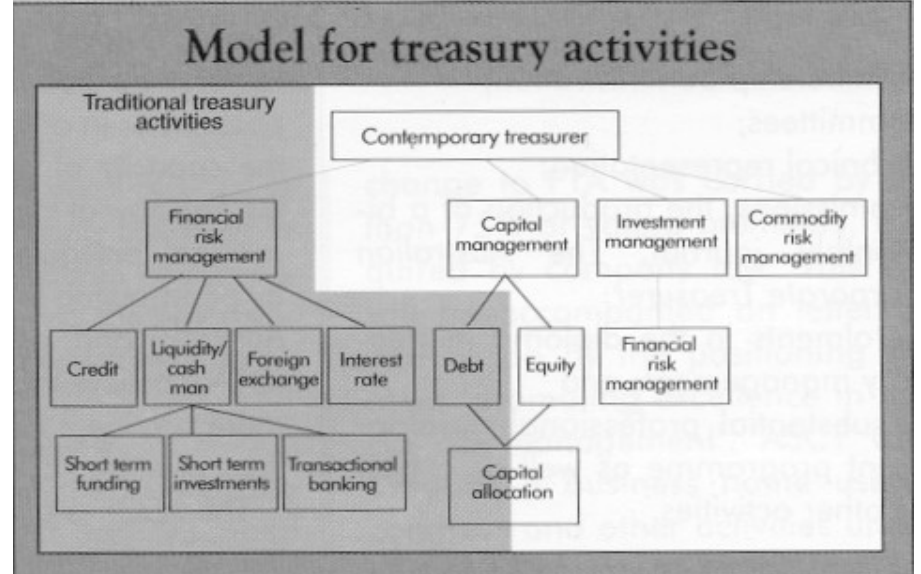
Figure 1 Model for treasury activities (St Clair